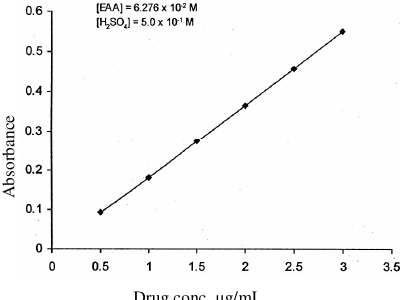
Figure 6. Beer’s law plot of REB – EAA- SO (M ) conc.H 2 4 1